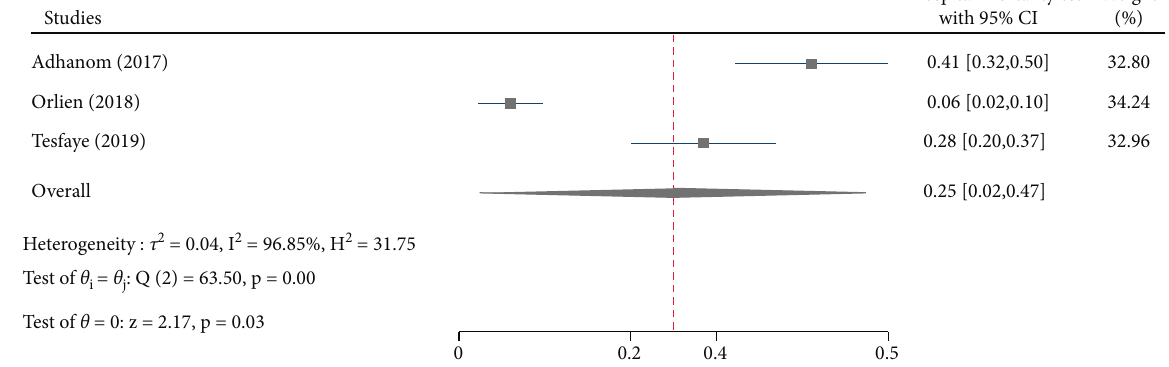
Figure 9: Forest plot depicting the estimated proportion of mortality among chronic liver disease patients in Ethiopia,